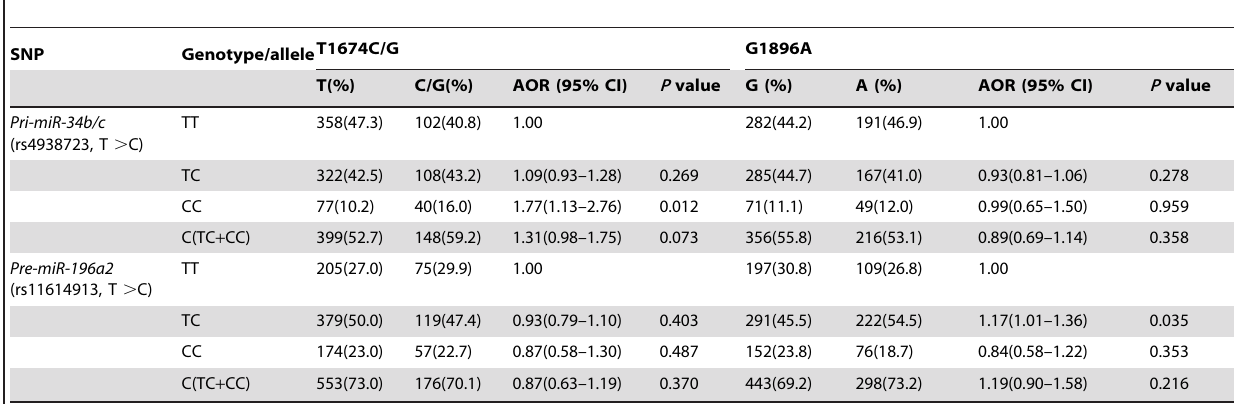
Table 3. The associations of the polymorphism with the HCC-related HBV mutations using the data of all HBV-infected subjects.